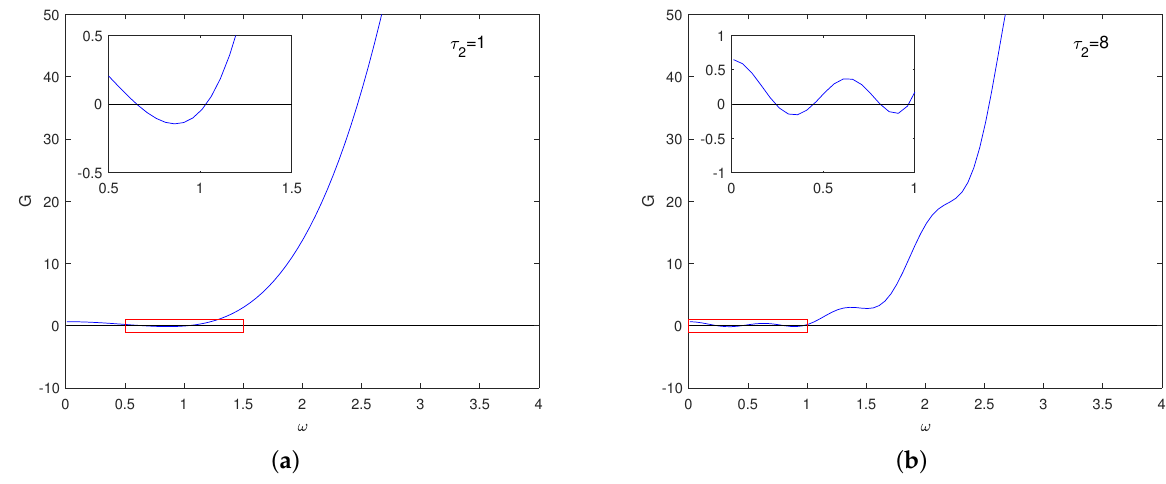
Figure 1. Roots of function G when l = 0.5, β 1 = 0.4, β 2 = − 0.4, k = − 0.5, ( a ) τ 2 = 1, ( b ) τ 2 =